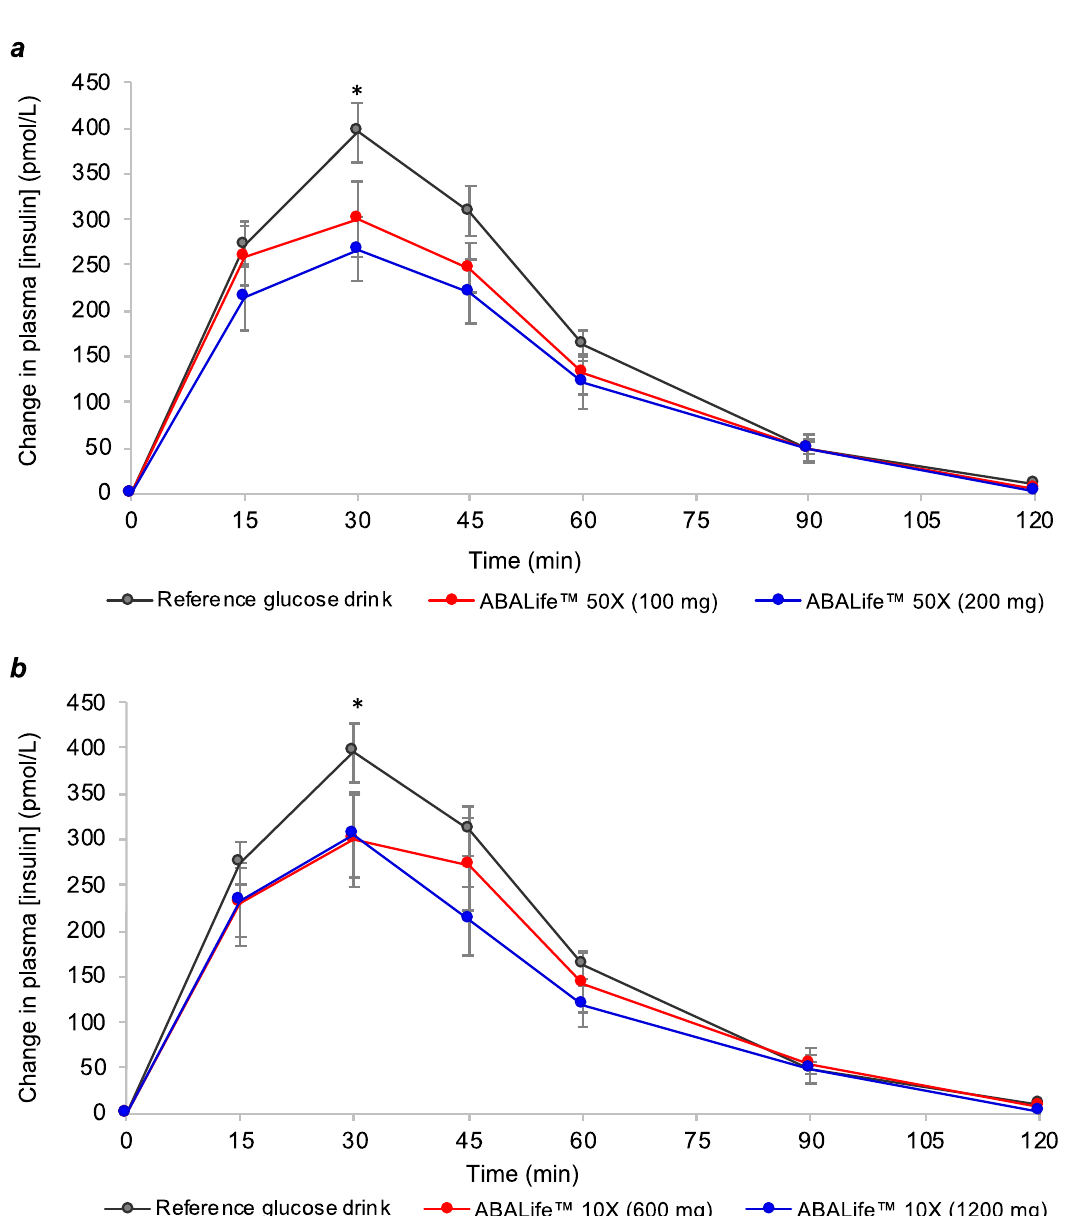
Figure 2. Change in postprandial 2 h plasma insulin concentration in healthy adults for ( a ) the two doses of ABA Life™ 50× fig fruit extract consumed with a glucose solution; ( b ) the two doses of ABA Life™ 10× fig fruit extract consumed with a glucose solution. Data are mean ± standard error mean (SEM), n = 10 for the 3 repeated tests in each participant for the reference glucose drink, and n = 10 for each test drink containing fig fruit extract (FFE). The two lower doses of each fig fruit extract contained 40 µg of abscisic acid (shown in red), and the two higher doses of each fig fruit extract contained 80 µg of abscisic acid (shown in blue). * indicates a significant difference between peak 30 min insulin concentration for each test drink containing FFE compared to the reference food ( P ≤ 0.019).